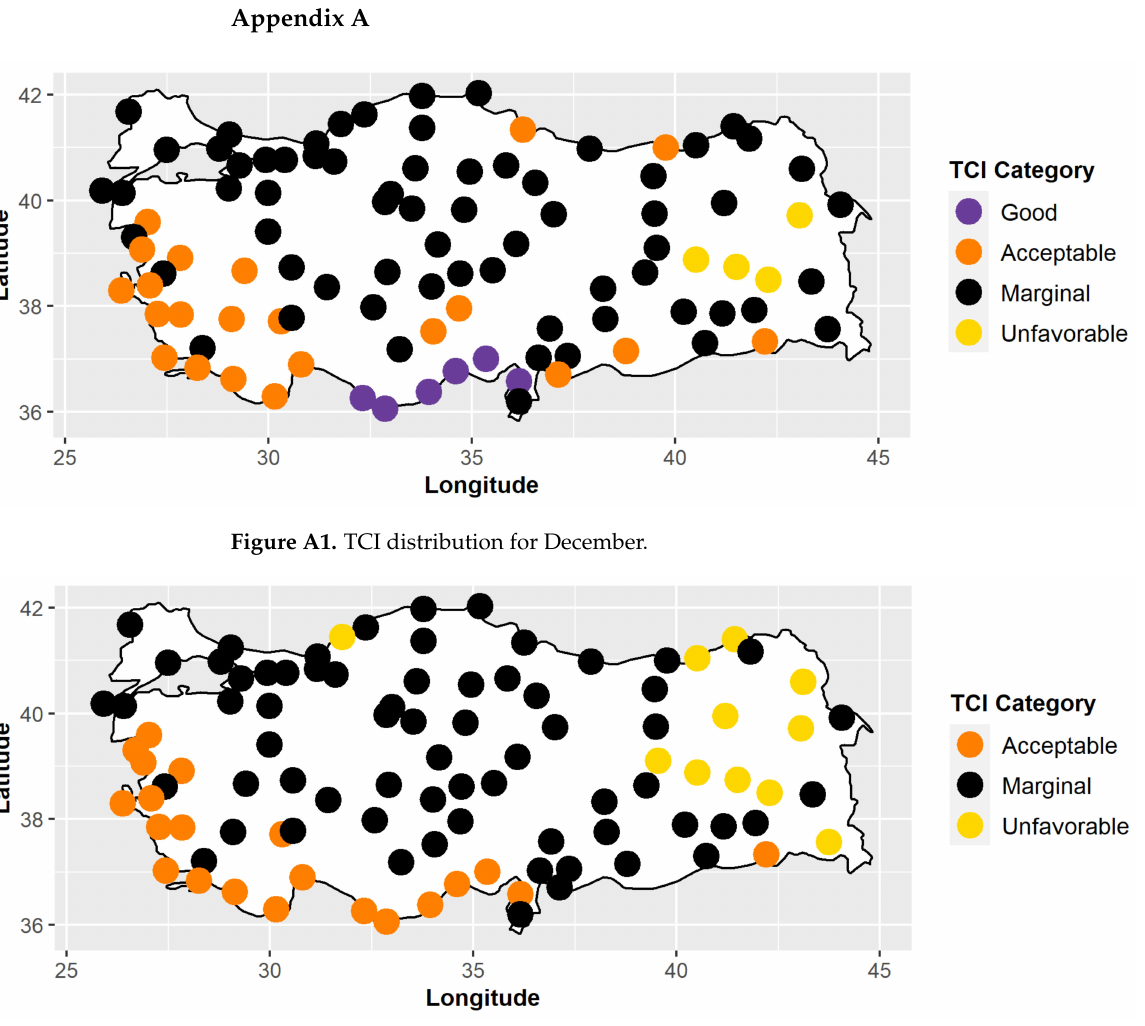
Figure A2. TCI distribution for